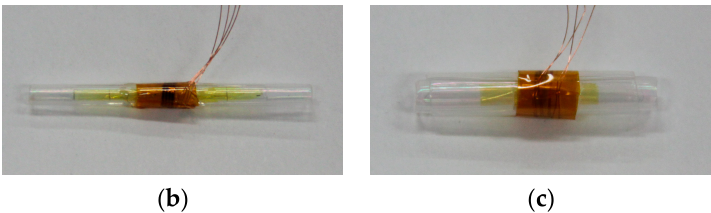
Figure 3. The fabricated catheter flow sensors: ( a ) Schematic view of catheter flow sensor; ( b ) Catheter flow sensor for bronchiole use (Di = 1.0 mm, Do = 1.8 mm); ( c ) Catheter flow sensor for bronchus use (Di = 2.0 mm, Do = 3.5 mm).